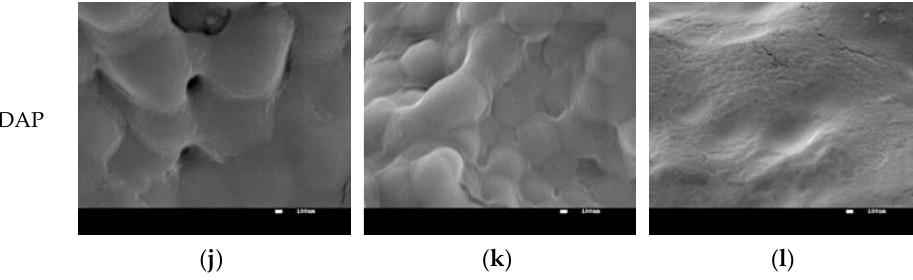
Figure 3. SEM pictures of polymer matrices of ionogels obtained in the study, after removing the ionic liquid. Polymer matrix obtained on the basis of different enes: ( a – c ) GBDA, ( d – f ) TAT, ( g – i ) TATT, and ( j – l ) DAP, and three different thiols: TMPTP, PETMP and PETMB.